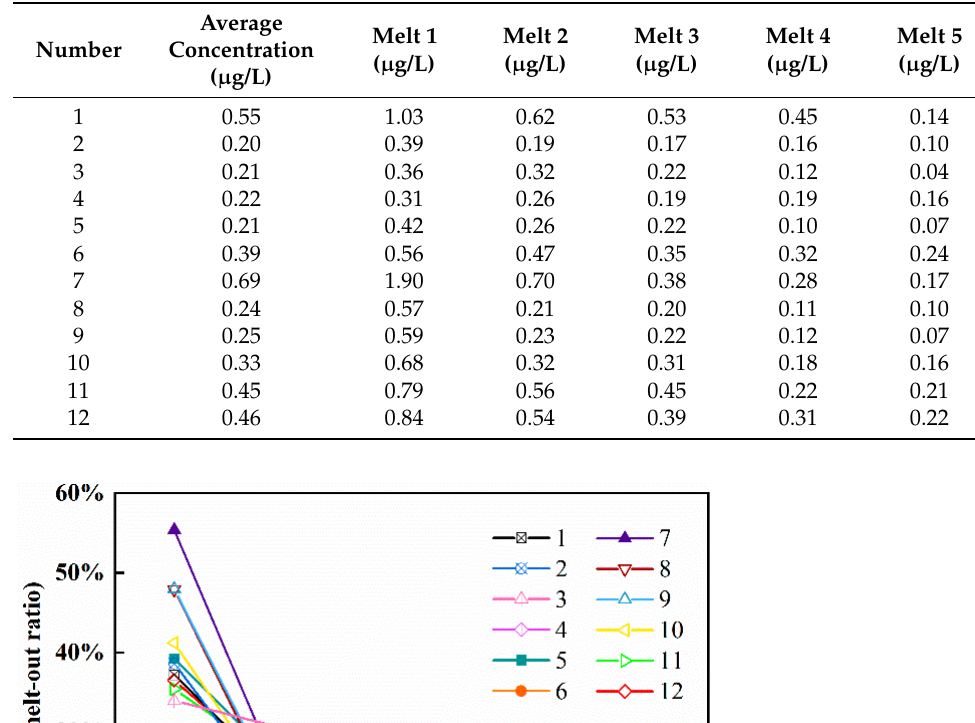
Table 2. Atrazine concentrations in ice meltwater: averaged value and partial values in each of 20%-fractions during melting.